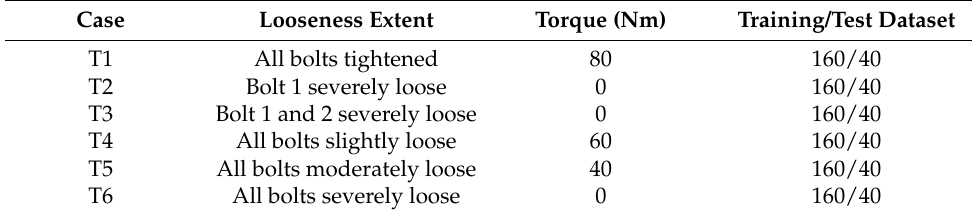
Table 4. Detailed arrangement of experimental cases.